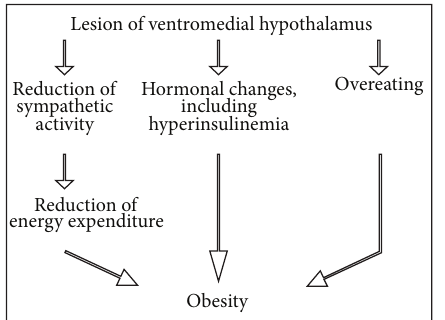
Scheme 4: Body weight gain during premenopausal